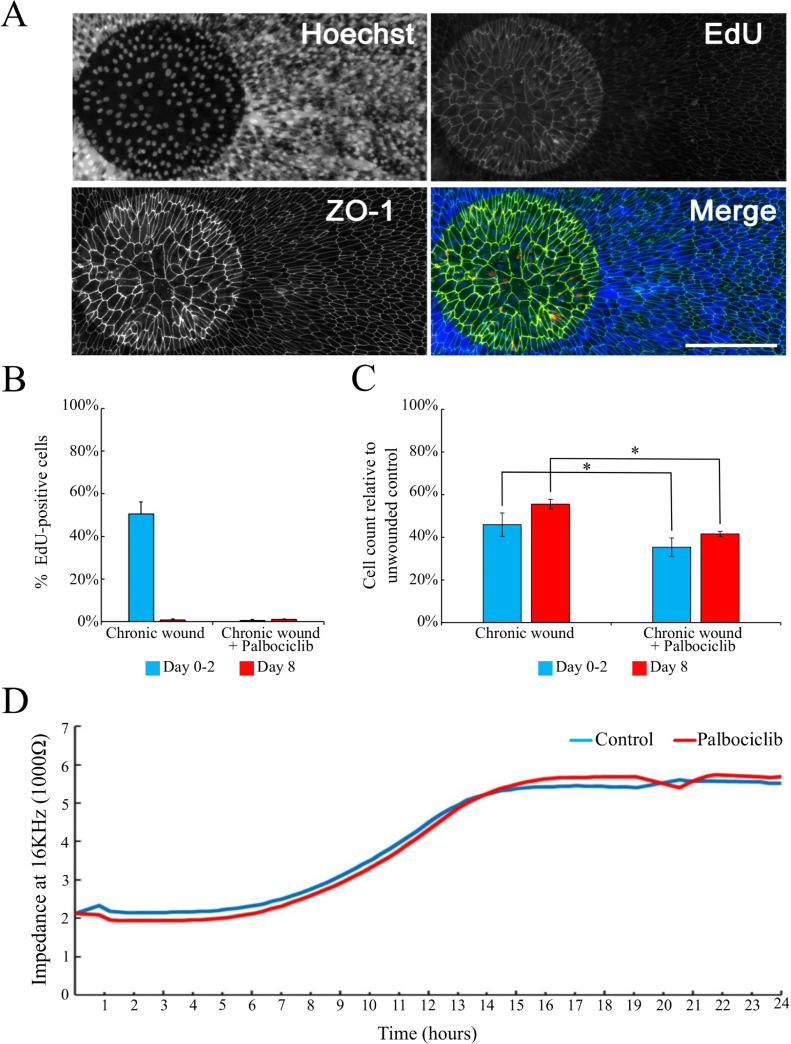
The proliferation of RPE cells is not required for wound closure.(A) Representative images of Hoescht, EdU, and ZO-1 labeled cell cultures two days after chronic wound treatments in the continual presence of 10 μM palbociclib. Scale bar is 200 μm. (B) Percent of EdU-positive cells 48-hours or 8-days after receiving chronic wounding treatments (mean ± SD, n = 4). (C) Inhibition of cell proliferation by the addition of palbociclib decreases the capability of RPE cells to restore control cell density over the electrode (mean ± SD, n = 3, * indicates p-value<0.01, see S3 Table). (D) Real-time impedance recording of RPE wound healing after chronic wound treatment in control and palbociclib treated cells. Trace is the average of three biological replicates.